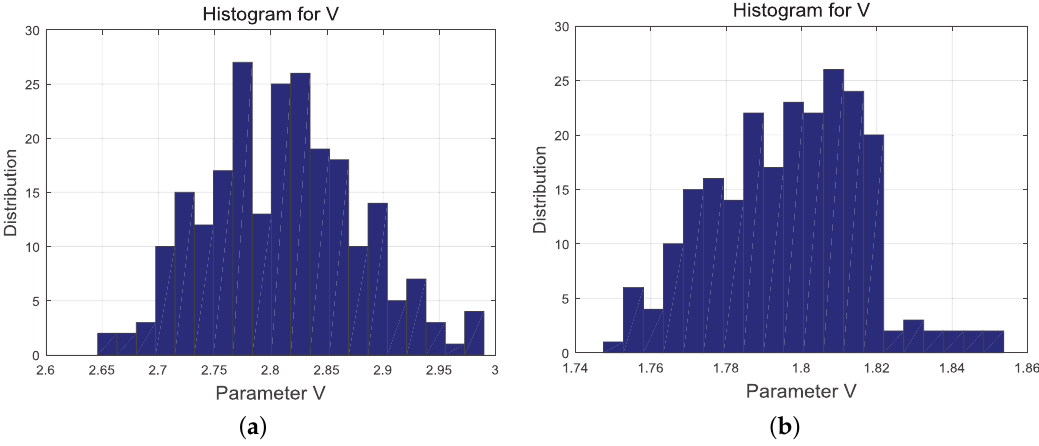
Figure 5. ( a ) Parameter estimation for the sea clutter; ( b ) Parameter estimation for the land